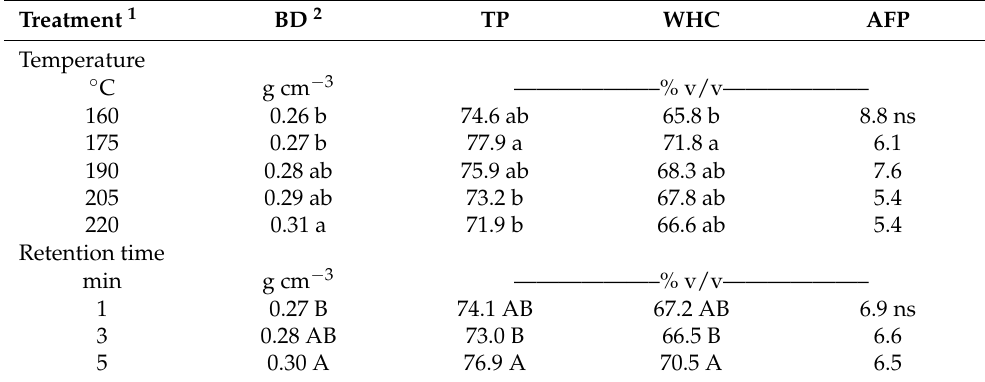
1 Abbreviations: BD = bulk density; TP = total porosity; WHC = water-holding capacity; AFP = air-filled porosity. 2 Means within each column followed by different lower-case or upper-case letters indicate significant differences among temperatures or retention times at α = 0.05. ns indicates no significant